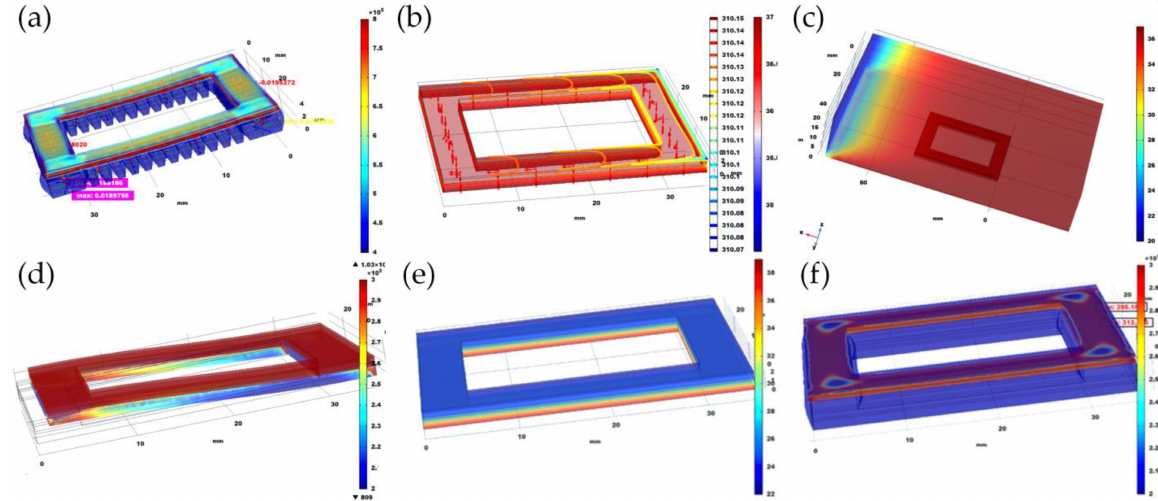
Figure 6. Simulation on COMSOL modelling of the temperature patch: ( a ) basic structure model with deformation of stress distribution contour on the device; ( b ) temperature distribution contour with surface air floats under cover cloth; ( c ) simulated pressure-stress distribution on device on bare skin without cover cloth; ( d ) deformation of patch subjected to 1N force in YZ direction; ( e ) simulation diagram of temperature measurement in bare skin area; ( f ) simulation diagram of stress distribution inside the patch after